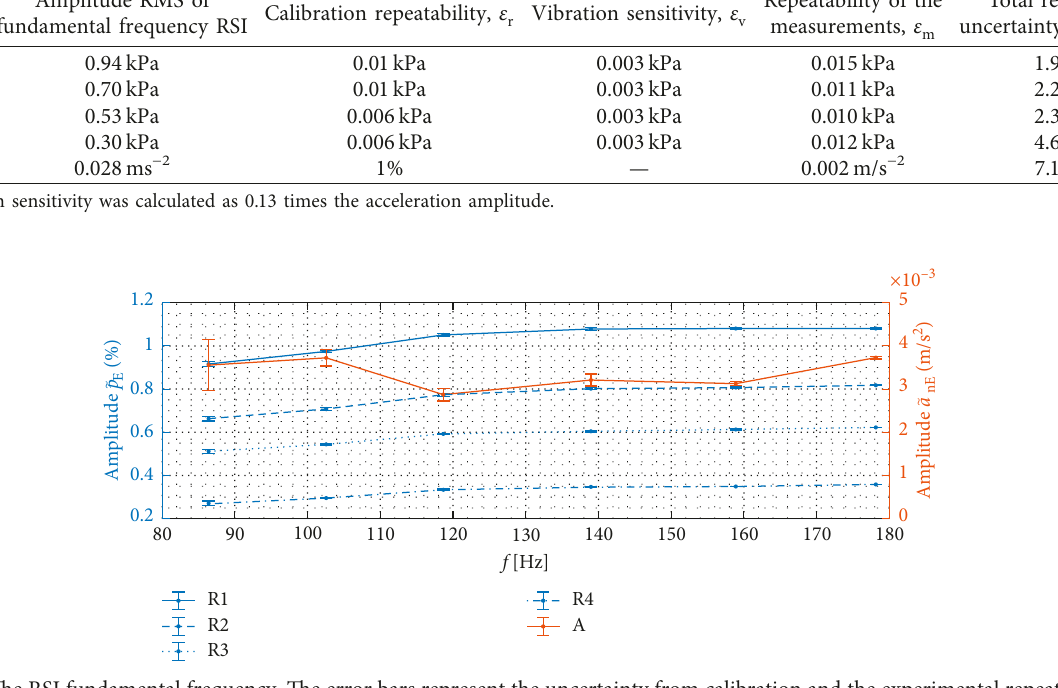
Figure 9: The RSI fundamental frequency. The error bars represent the uncertainty from calibration and the experimental repeatability of the amplitudes.